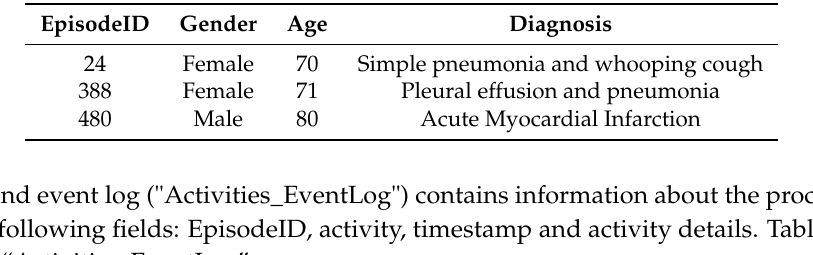
Table 1. Example of an event log at case identifier level.